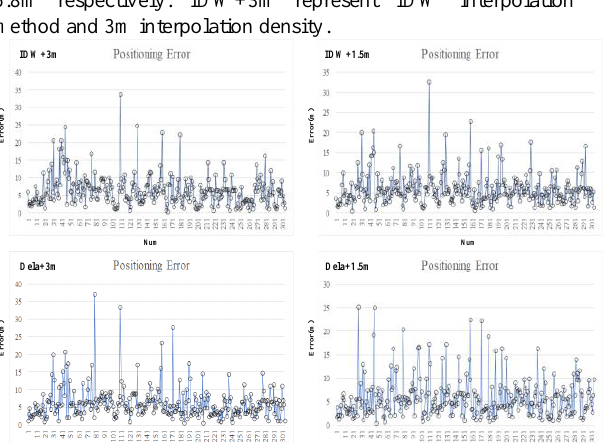
Figure 12. Positioning error with different interpolation methods (IDW and Delaunay) and interpolation density (3m and 1.5m) considering near relation.